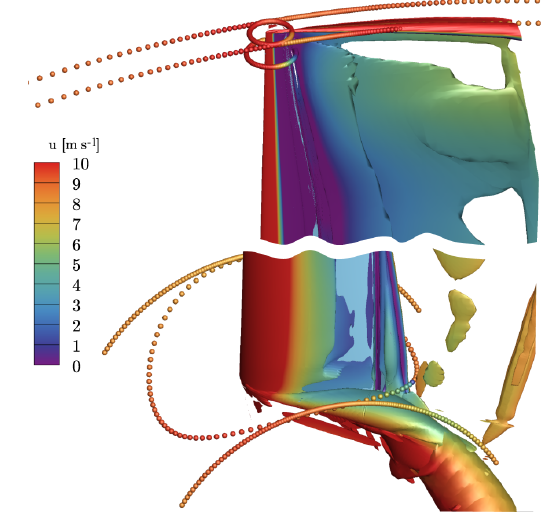
Figure 11. Extraction of axial velocity in the inertial frame near the tip and the root using the reduced axial velocity method (Johansen and Sørensen, 2004) (circular arcs) and the line average (closed curves) (Jost et al., 2018) method.